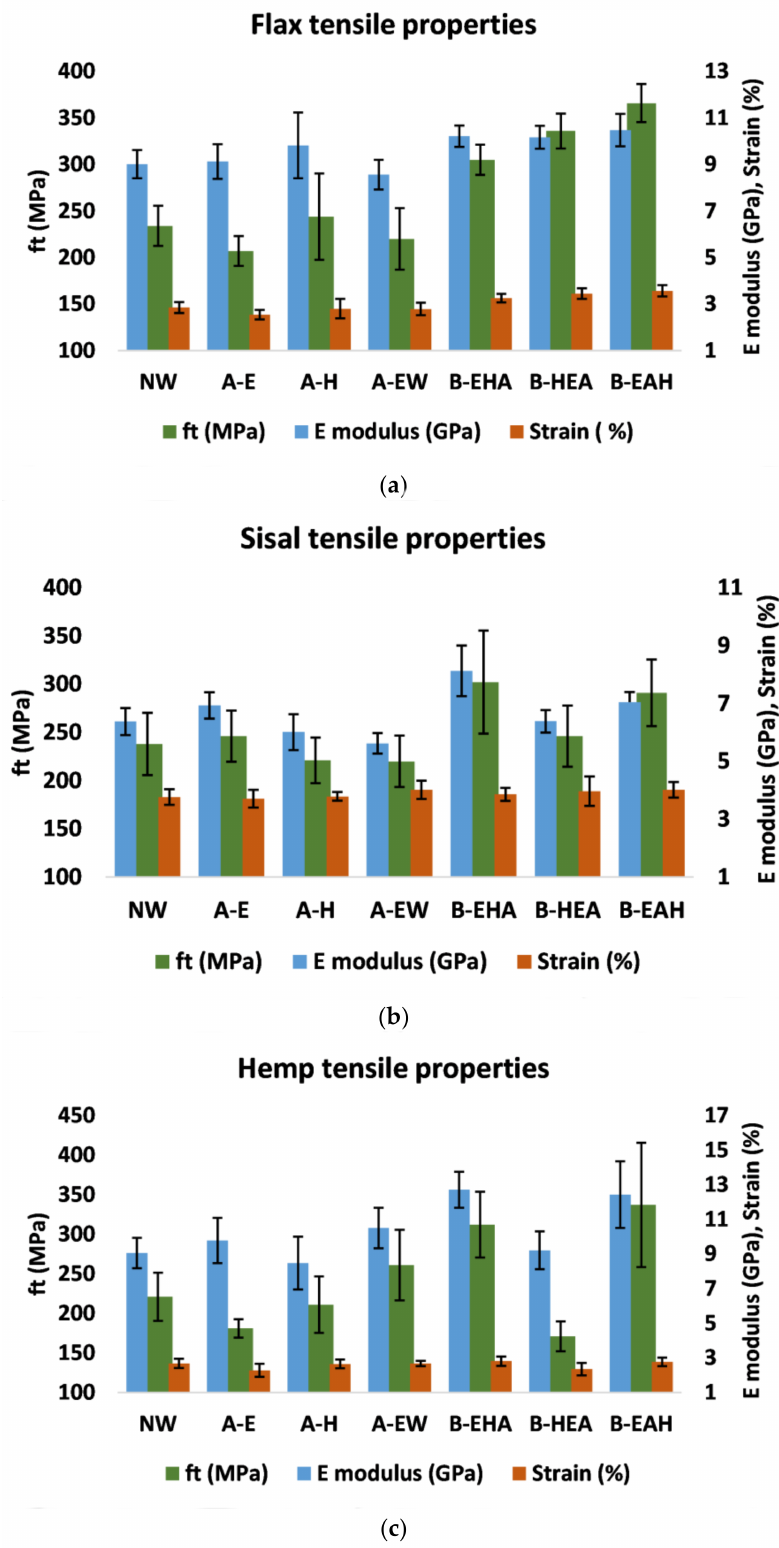
Figure 10. Tensile properties of ( a ) flax, ( b ) sisal and ( c ) hemp with corresponding standard